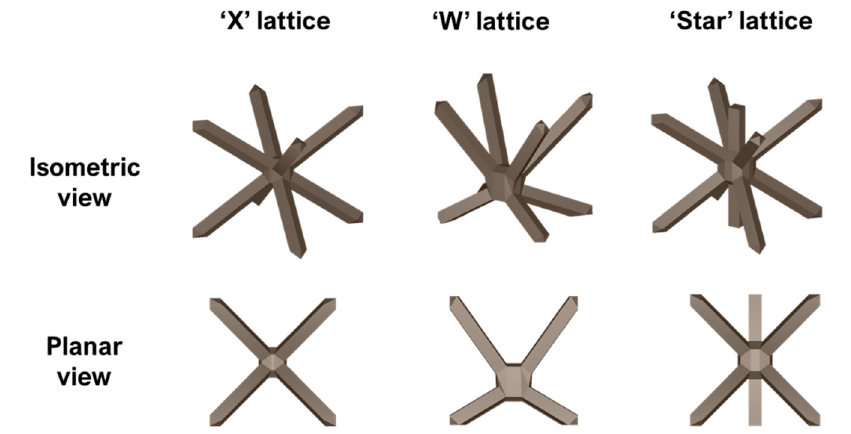
Figure 3. The isometric and planar views of the ‘X’ lattice ( left ), ‘W’ lattice ( center ) and the ‘Star’ lattice ( right ). The overhang angles for the members are ensured to be more than 45 degrees from the horizontal to ensure supportless printing.